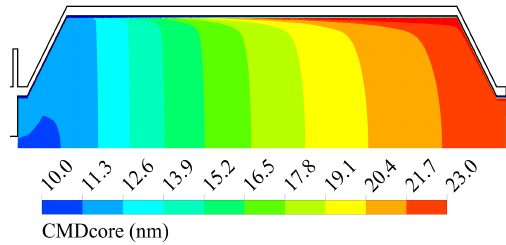
Figure 10. The core mode CMD in the aging chamber region when there is [ H 2 SO 4 ] = 1 . 47 × 10 11 cm − 3 in raw exhaust of R case with n sa = 0 . 25. The figure is scaled vertically with a factor of